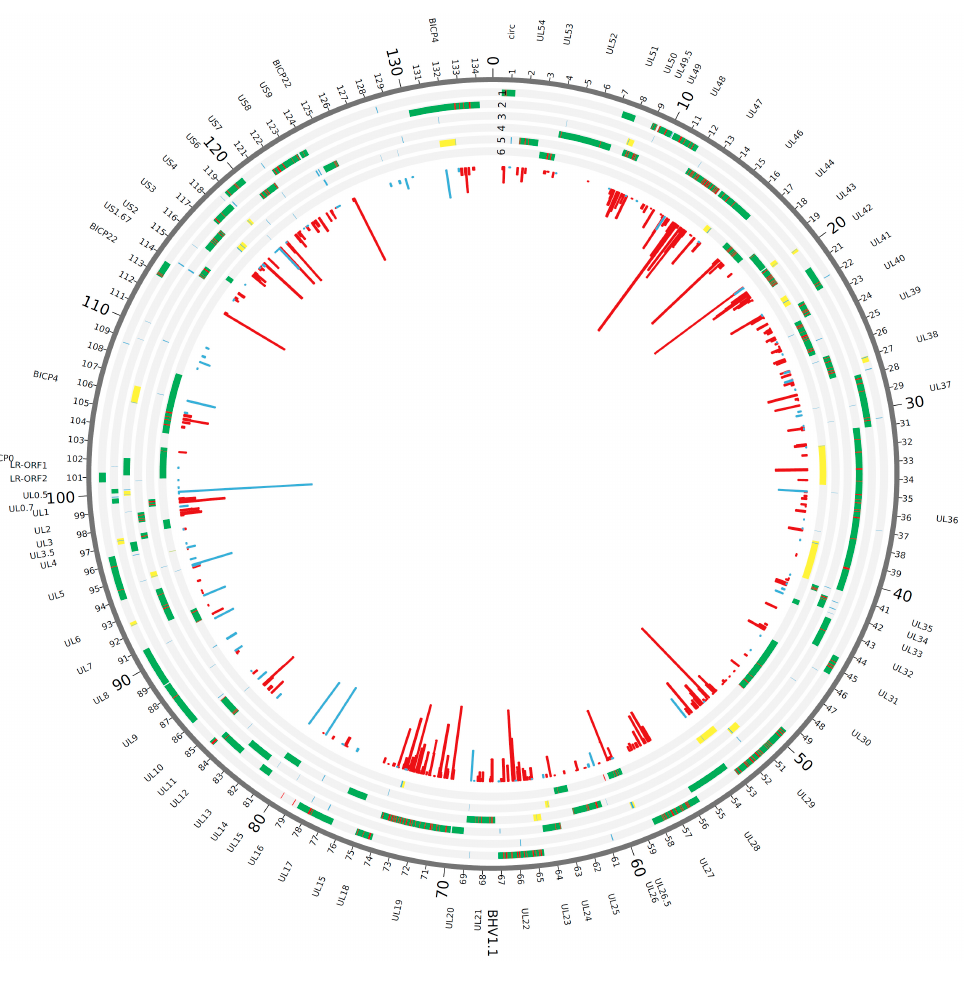
Figure 1. MS/MS peptides mapped to the BoHV-1 genome. The 134 kb genome is displayed in the six possible reading frames (six different tracks). Currently annotated viral ORFs are shown in green in their corresponding reading frame; gene names are shown on the outside of the circle. MS/MS spectra are shown both as a histogram in the center as well as mapped onto the corresponding reading frame. Spectra mapping to coding regions are shown in red, while intergenic spectra (refer to text for explanation) appear in blue. Twenty-one viable ORFs surrounding intergenic spectra are shown in yellow in the corresponding reading frame. Table 2. Summary of proteogenomic mapping results.